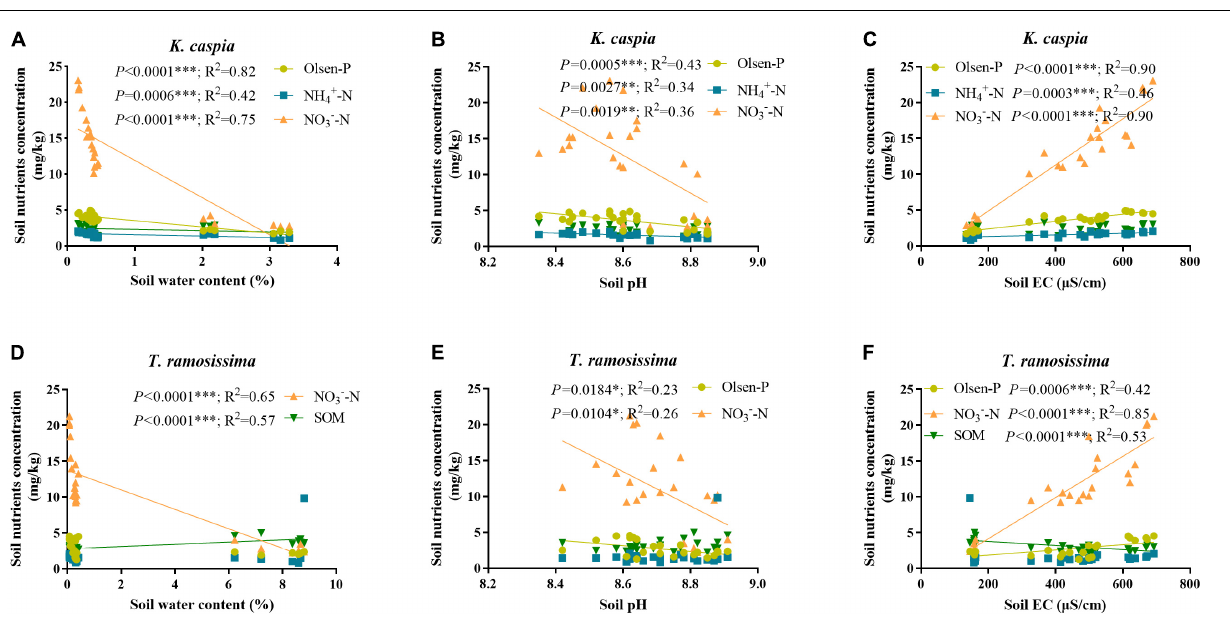
FIGURE 2 | Correlations between the soil basic nutrients and soil water content, pH, and electrical conductivity (EC). The correlation between soil basic nutrients under K. caspia and soil water content (A) , pH (B) , and EC (C) , and under T. ramosissima and soil water content (D) , pH (E) and EC (F) , respectively. The values of R 2 and p are shown only if p < 0.05. * p < 0.05, ** p < 0.01, *** p < 0.001. TABLE 3 | Mass ratios for total leaf nitrogen (N) to total leaf phosphorus (P) and to P in each foliar P-containing fraction of Karelinia caspia (K. caspica) and Tamarix ramosissima (T. ramosissima)